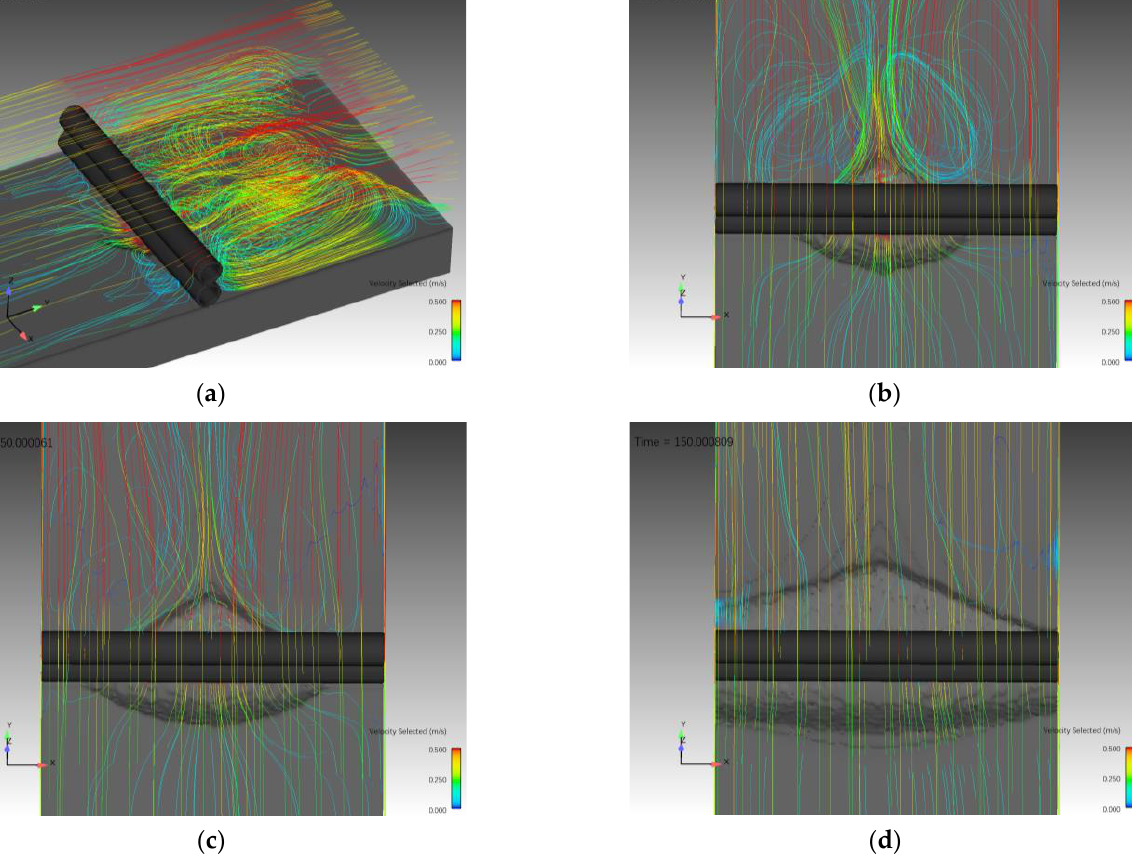
Figure 11. Streamlines around the pipelines for α = 0°: ( a ) t = 5 s; ( b ) t = 25 s; ( c ) t = 50 s; ( d ) t = 150 s. Figure 12. Streamlines around the pipelines for α = 0 ◦ : ( a ) t = 5 s; ( b ) t = 25 s; ( c ) t = 50 s; ( d ) t = 150